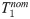
Skeletal muscle kf determined by conventional saturation transfer approach and T1nom approach with 1D-ISIS/1D-CSI localization.(A) MR image of calf muscle showing the locations of the 1D-CSI voxels. (B) Series of spectra for conventional saturation transfer approach. The peak localization are as α-ATP at -7.6 ppm, γ-ATP at -2.5 ppm, PCr at 0.0 ppm, phosphodiester (PDE) at 3.2 ppm and inorganic phosphates (Pi) at 5.2 ppm. γ-ATP peak is visible in the top spectrum and is selectively saturated for other spectra. Saturation time was progressively increased and PCr peak intensity decreases with the increasing duration of saturation of γ-ATP. (C) Stack of spectra showing Mc (without ATP saturation, right) and Ms (with ATP saturation, left) using T1nom method.